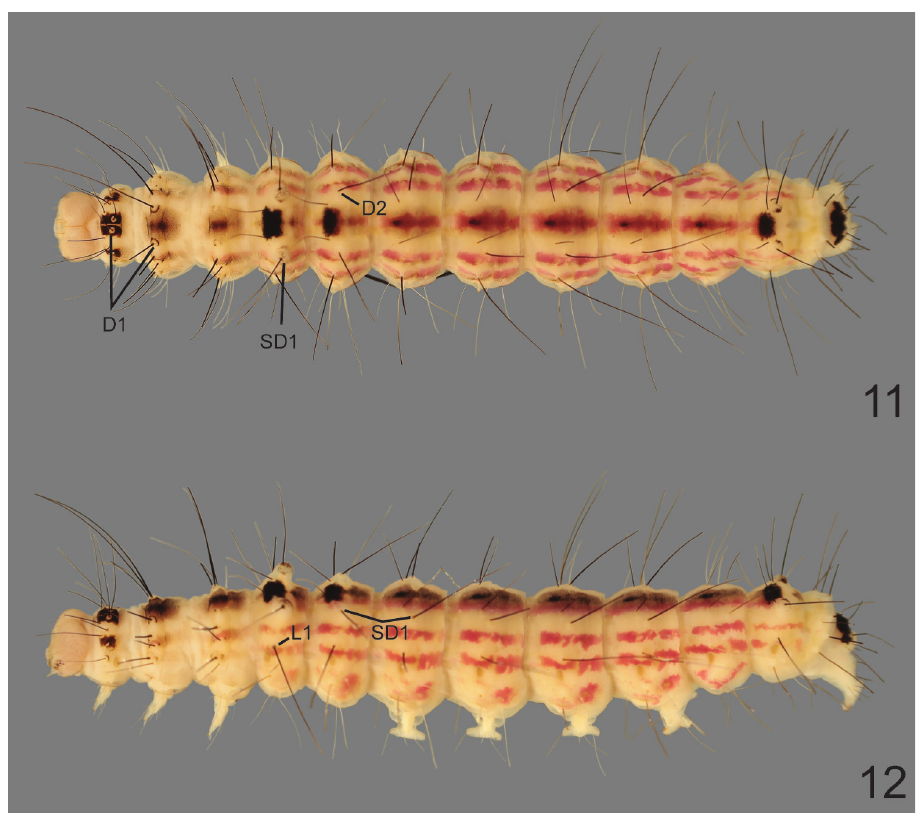
Figures 11–12. Larva of Gadirtha fusca sp. n. (preserved in alcohol). 11 dorsal 12 Larva (Figs 11–14): Length: 28.0–33.5 mm ( n = 6). Coloration and pattern. Head – Yellow. Thorax – T1 with medial rectangular black spots surrounding D1, D1 pinnacula yellow, irregular shaped black spot between XD2 and SD1, black spinules distal to all black spots; T2 and T3 with patch of black spinules between D1s, between D2 and SD2, distal to L group, and dorsal to SV group. Abdomen – yellow; dorsal line distinct black, ovate spots on A1, A2, and A8, remainder of segments with small round spots, spiculate; subdorsal, lateral, and spiracular lines pale green, spiculate; A10 with D1s surrounded by large, irregular shaped black spot, pinnacula yellow. Morphol- ogy. Head – Front flat; hypognathous; cutting edge of mandible with 3 shallow teeth, dorso-medial internal surface with large molar-like tooth, round and peg-shaped; epi- cranial suture elongate; epicranial notch moderately emarginated dorsally; F1, AF1 equal in length, AF2 longer; C1 shorter than C2; P1 dorsal to AF2, P2 inline with and dorsal to P1, shorter than P1; L1 fine, shorter than A3; S2 distal to stemma 1, shorter than S1; S1 ventral to stemma 3; stemmata 1–3 large and equal in width, larger than stemmata 4–6; spinneret cylindrical, equal in length to labial palp. Thorax – Spiculate; verrucae absent; T1 with D1, D2, XD1, and XD2 elongate, black; SD1 and SD2 on